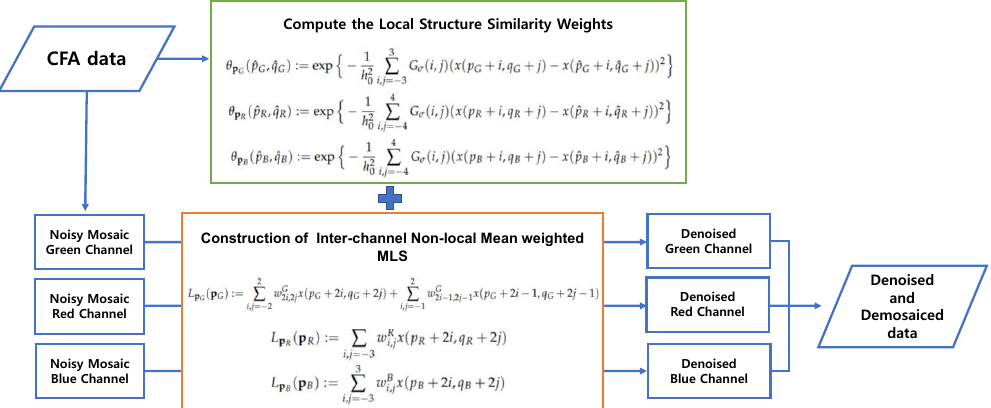
Figure 3. Block diagram of the proposed algorithm. MLS—moving least square.